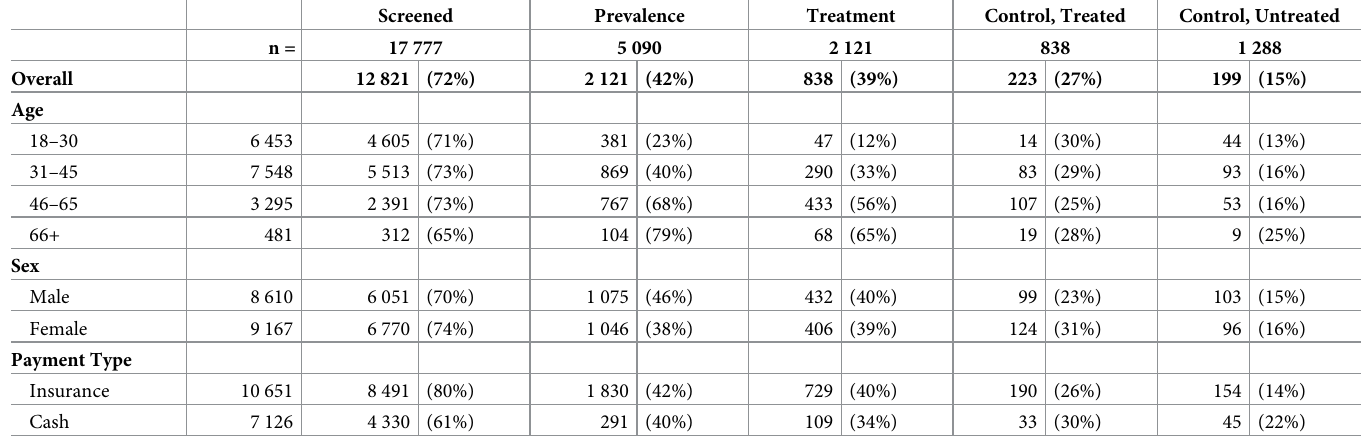
Table 2. Overview of screening, prevalence, and treatment. Screened Prevalence Treatment Control, Treated Control,